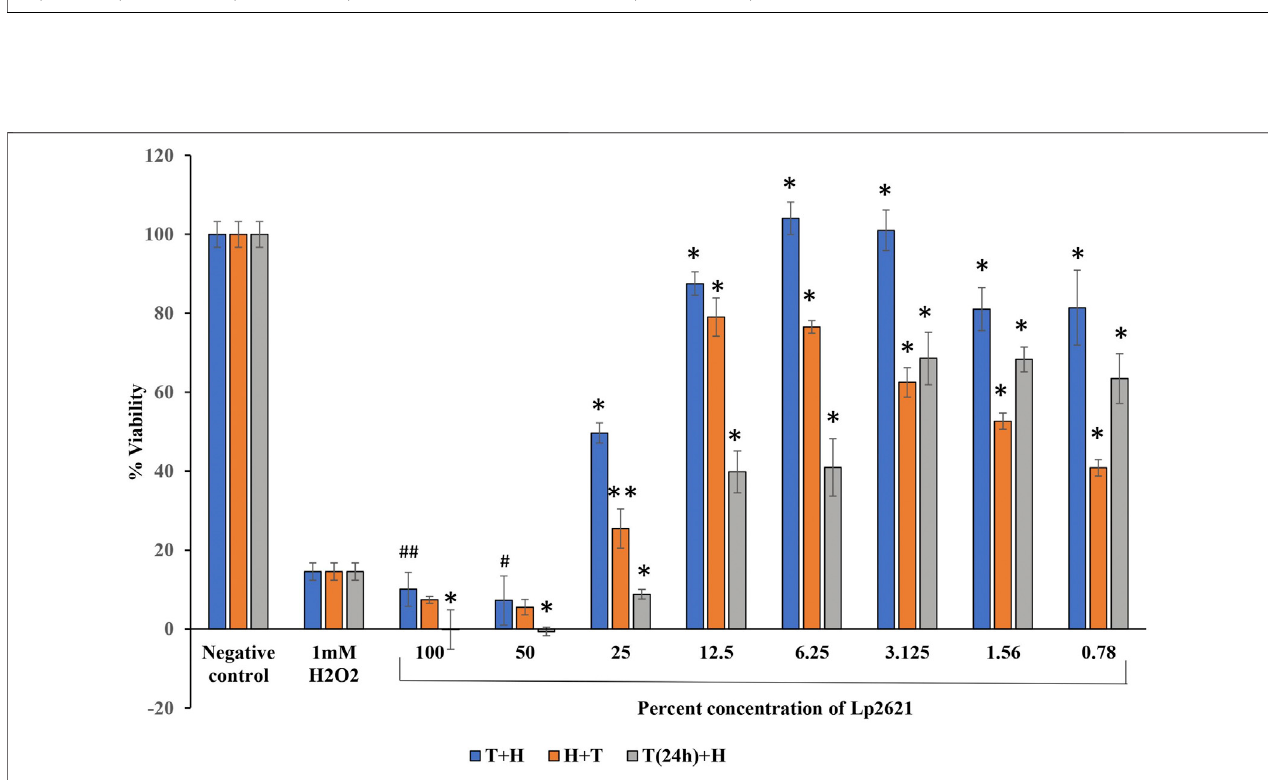
FIGURE 5 | Percent viability of A549 cells treated with Lp2621.